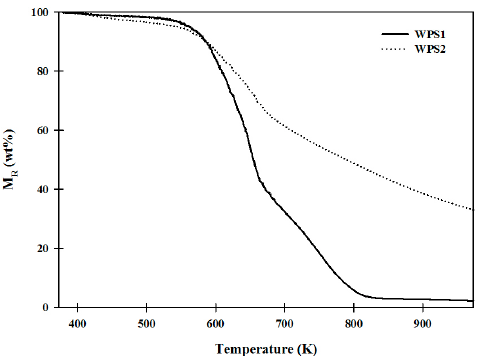
Figure 1. TGA curves of residual mass fraction (M R ) vs. temperature (T) for WPS with conditions: pre-heating at 378 K for 20 min, heating rate of 10 K/min, sample weight of 20 mg.